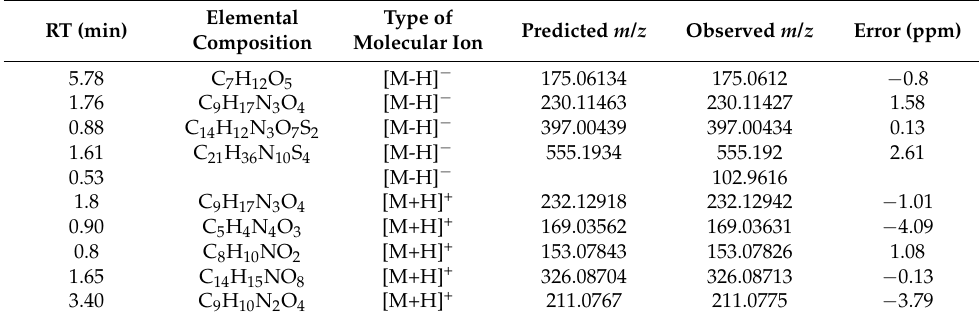
Table 2. Single MS accurate mass data generated using METLIN